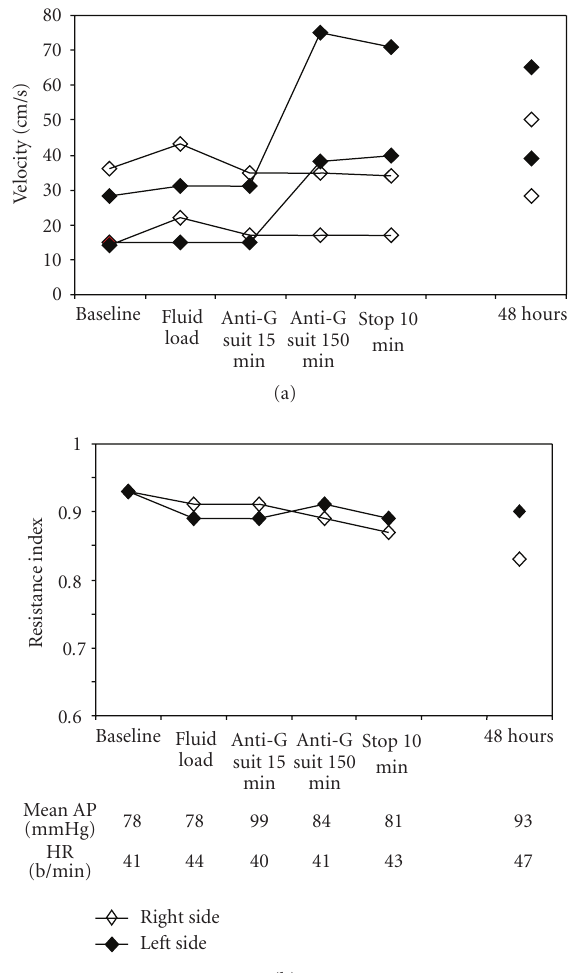
Figure 2: MRI di ff usion-weighted images showing left superficial MCA infarct. (a) 24 hours after stroke onset, (b) 5 days after stroke